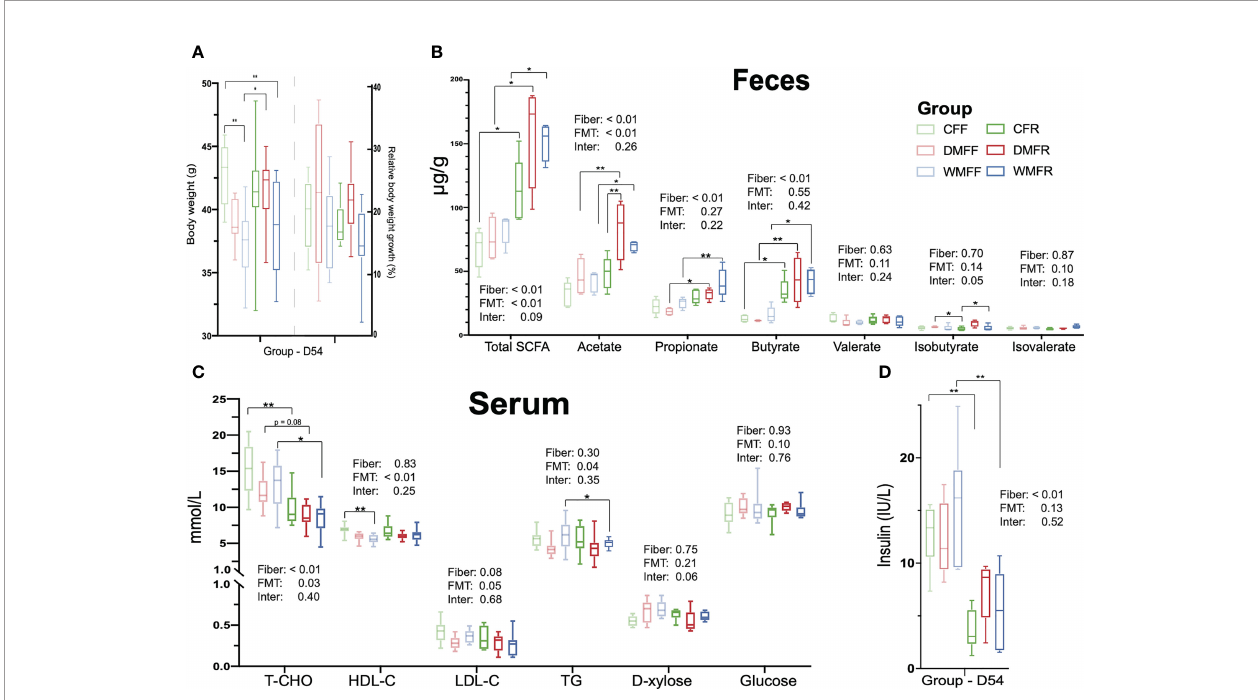
FIGURE 2 | Effect of fecal microbiota transplantation (FMT) together with dietary fi ber intervention on mice at day 54. (A) Box plots of body weight. (B) Fecal short- chain fatty acids (SCFAs). (C, D) Serum biochemical characteristics in mice. Statistical differences among individual groups were evaluated using one-way ANOVA, and signi fi cance is de fi ned as * p < 0.05; ** p <